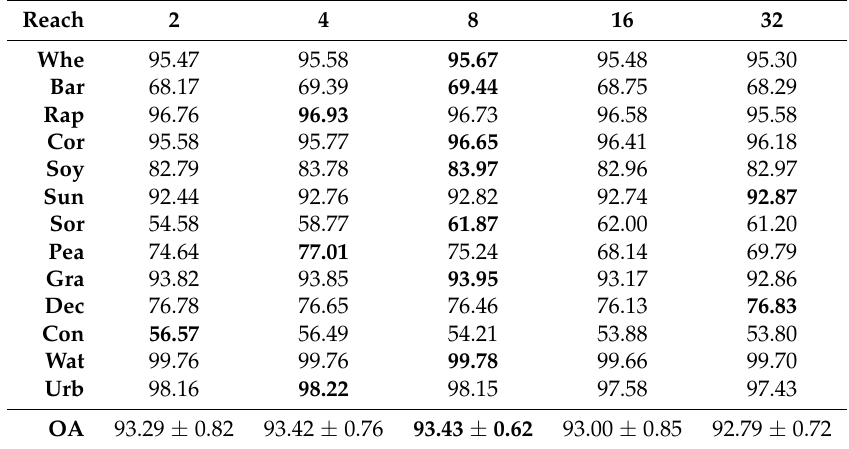
Table 5. Averaged Overall Accuracy (OA), ± one standard deviation, and F-Score values for five reach values. Bold values highlights the highest